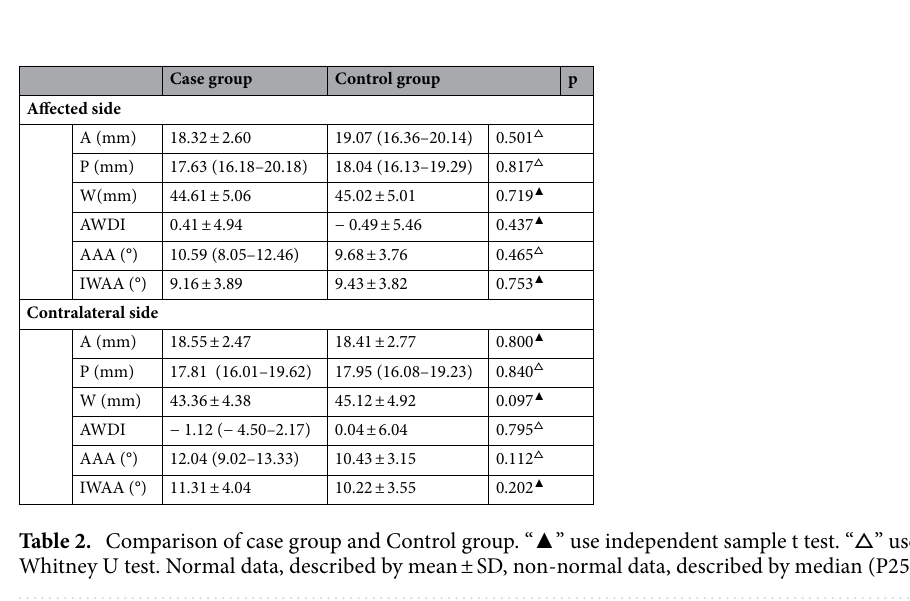
Table 1. Reliability of CT acetabular measurements (n = 20). *The values are given as the intraclass correlation coefficient, with the 95% confidence interval in parentheses.